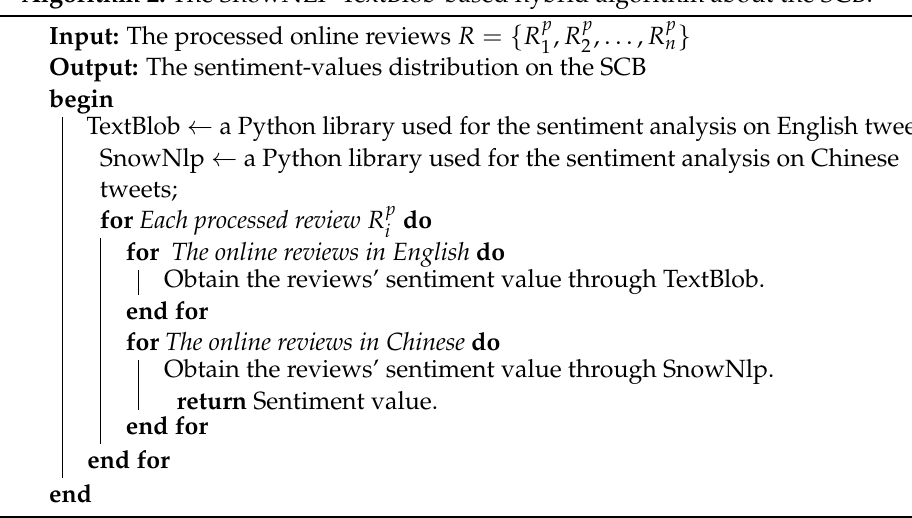
Algorithm 2: The SnowNLP-TextBlob-based hybrid algorithm about the